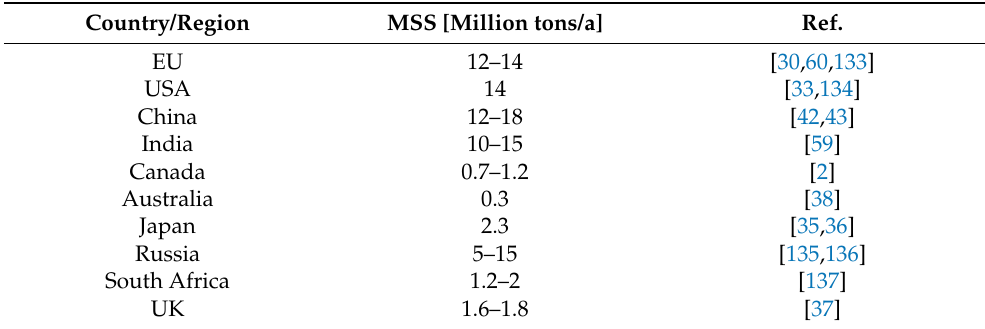
Table 4. Annual production of MSS as DS for different